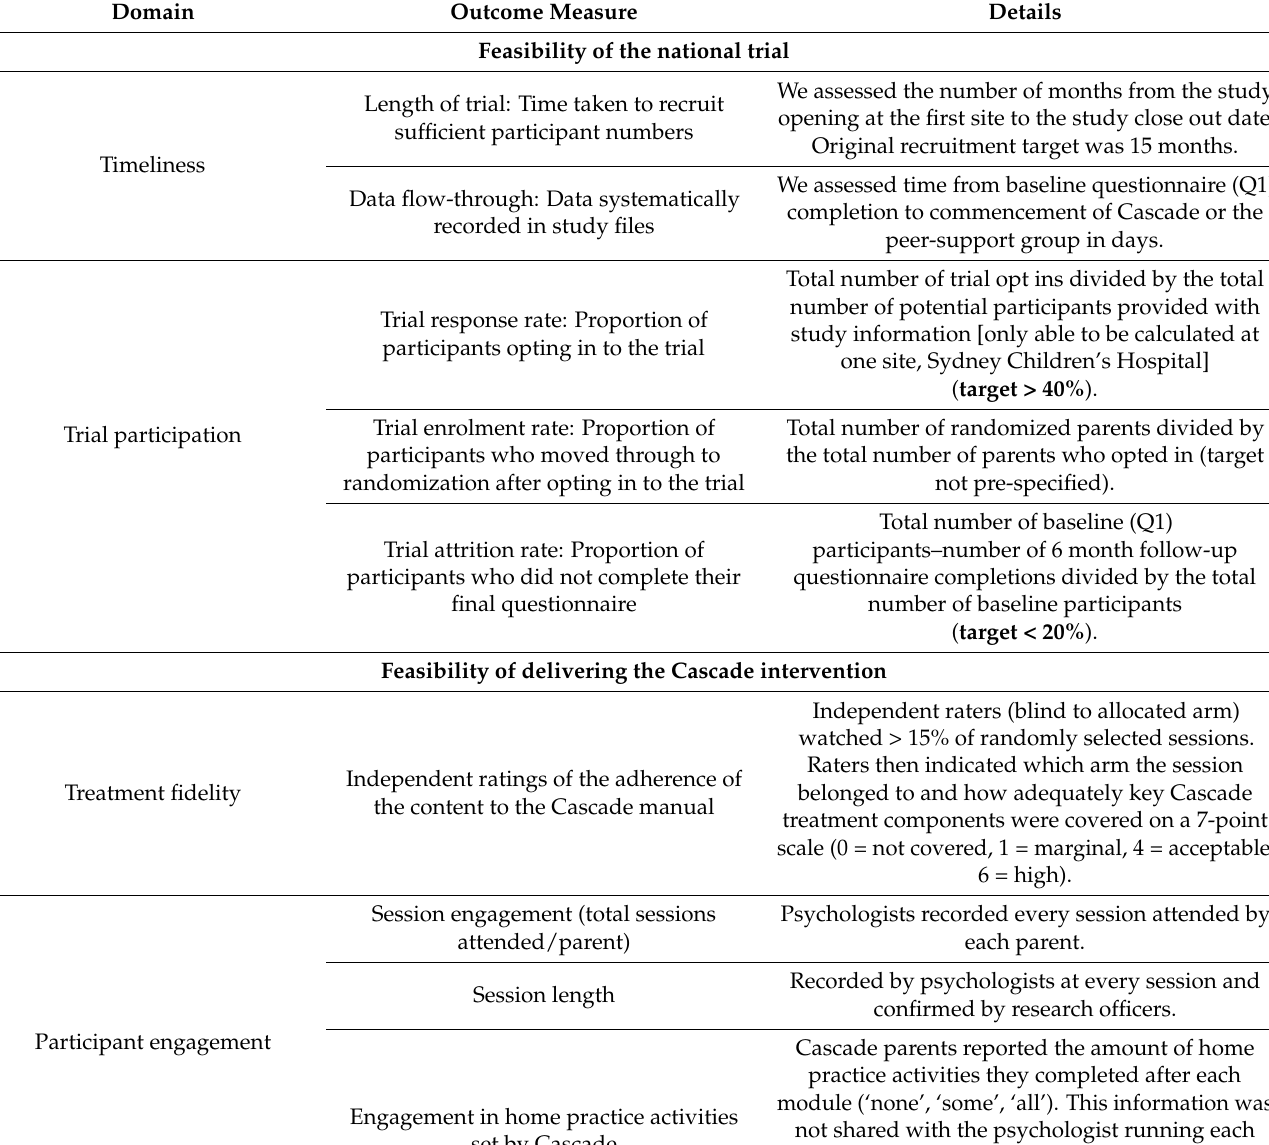
Table 2. Measures used to assess Cascade and the Cascade